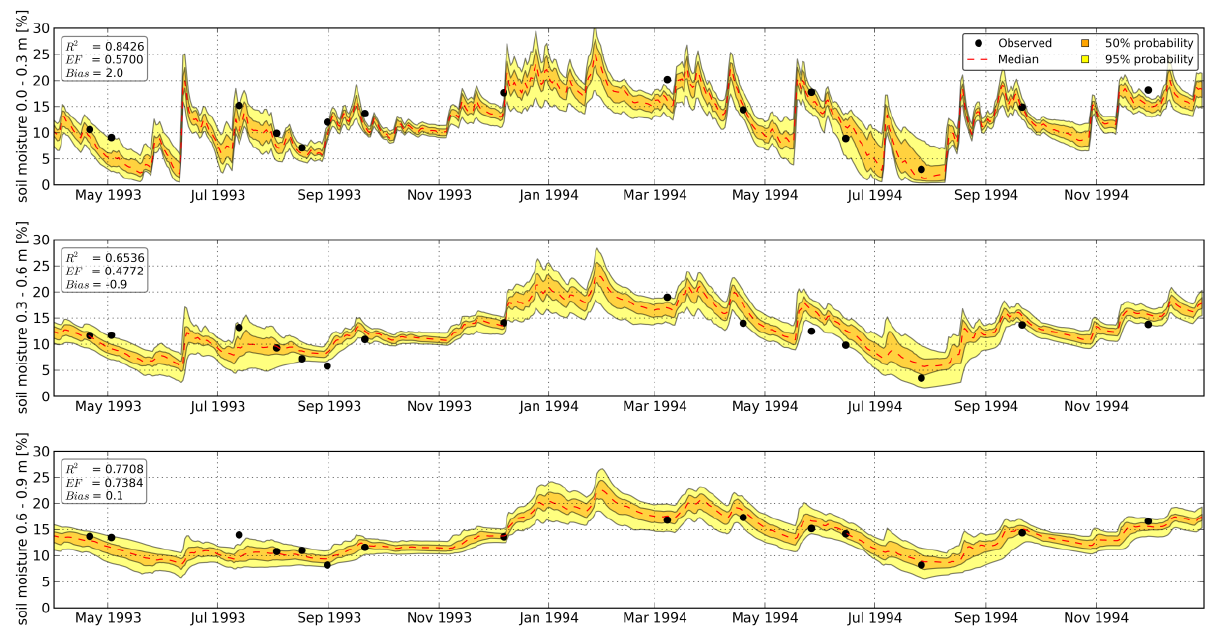
Fig. 2. Probabilistic time series for the simulation of soil moisture with behavioural (NSE > 0, bias < ± 10% soil moisture and R 2 > 0 . 3) CMF–PMF model runs at site 1 for three soil depths. Inserts: the likelihood functions quantify the median of the prediction range.